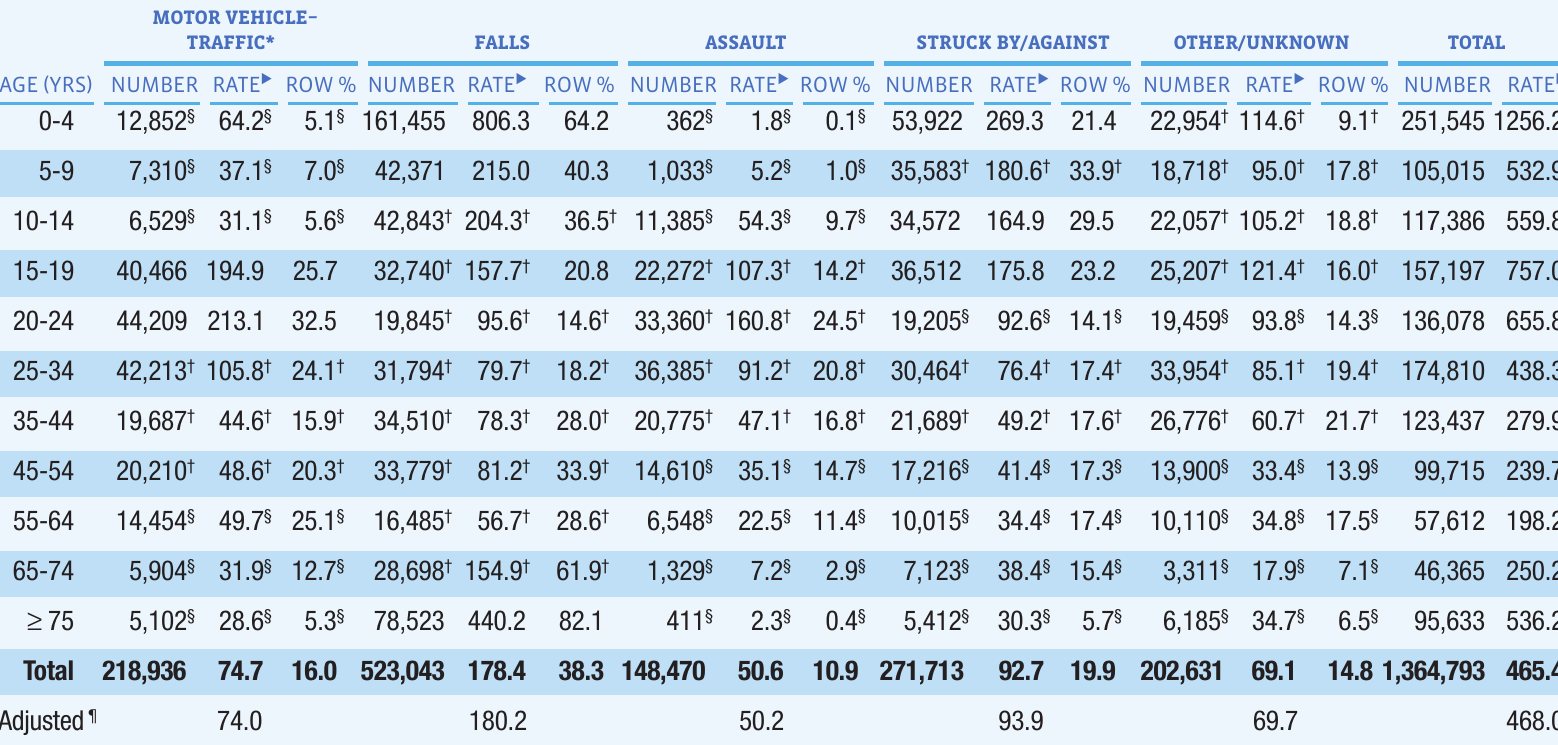
TABLE 5: Estimated Average Annual Numbers, Rates, and Percentages of Traumatic Brain Injury-Related Emergency Department Visits, by Age Group and External Cause, United States,